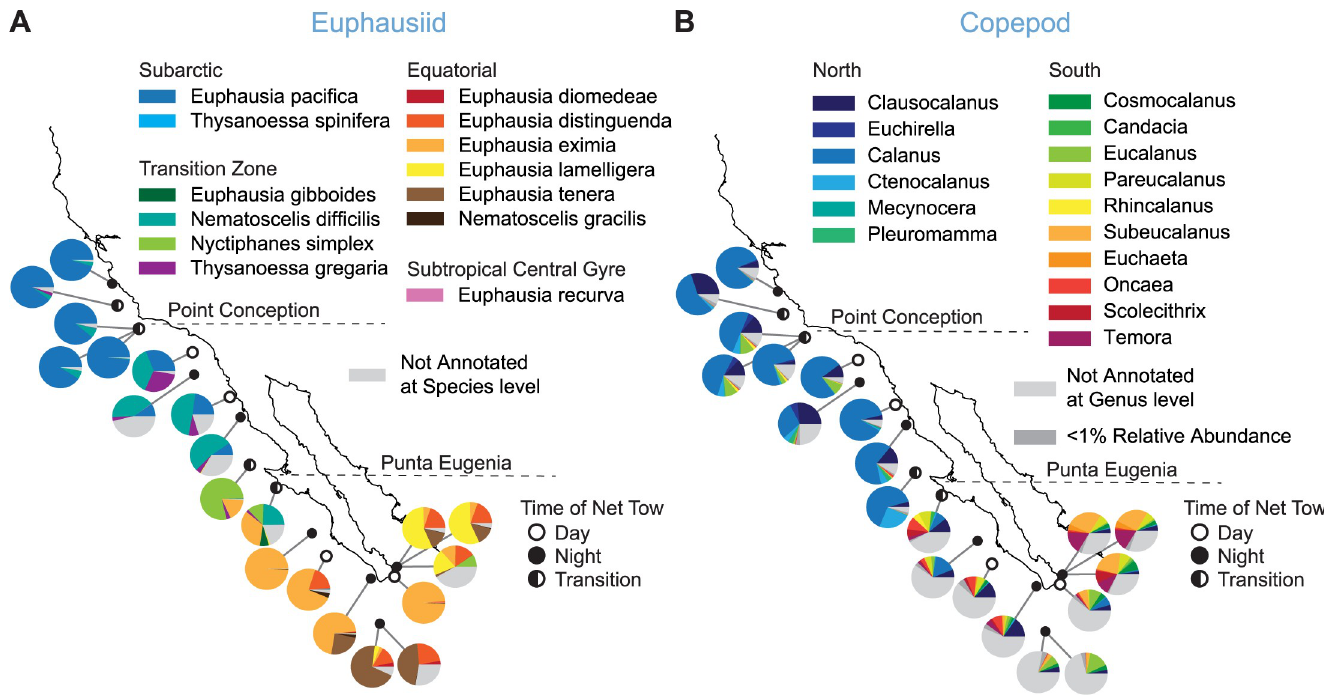
Fig 7. Euphausiid and copepod community composition by sample. (A) Proportion of reads annotated to species out of total reads annotated to the family Euphausiidae within each sample from the Banzai COI dataset. Species are organized according to ecological categories from Pare´s-Escobar, Lavaniegos, & Ambriz- Arreola, 2018. (B) Proportion of reads annotated to copepod genera out of total reads annotated to copepods within each sample from the Banzai COI dataset. Genera are organized in region of highest relative abundance and by Family and Genus. Labeled genera only include genera with � 0.1% total rarefied reads in at least one sample.